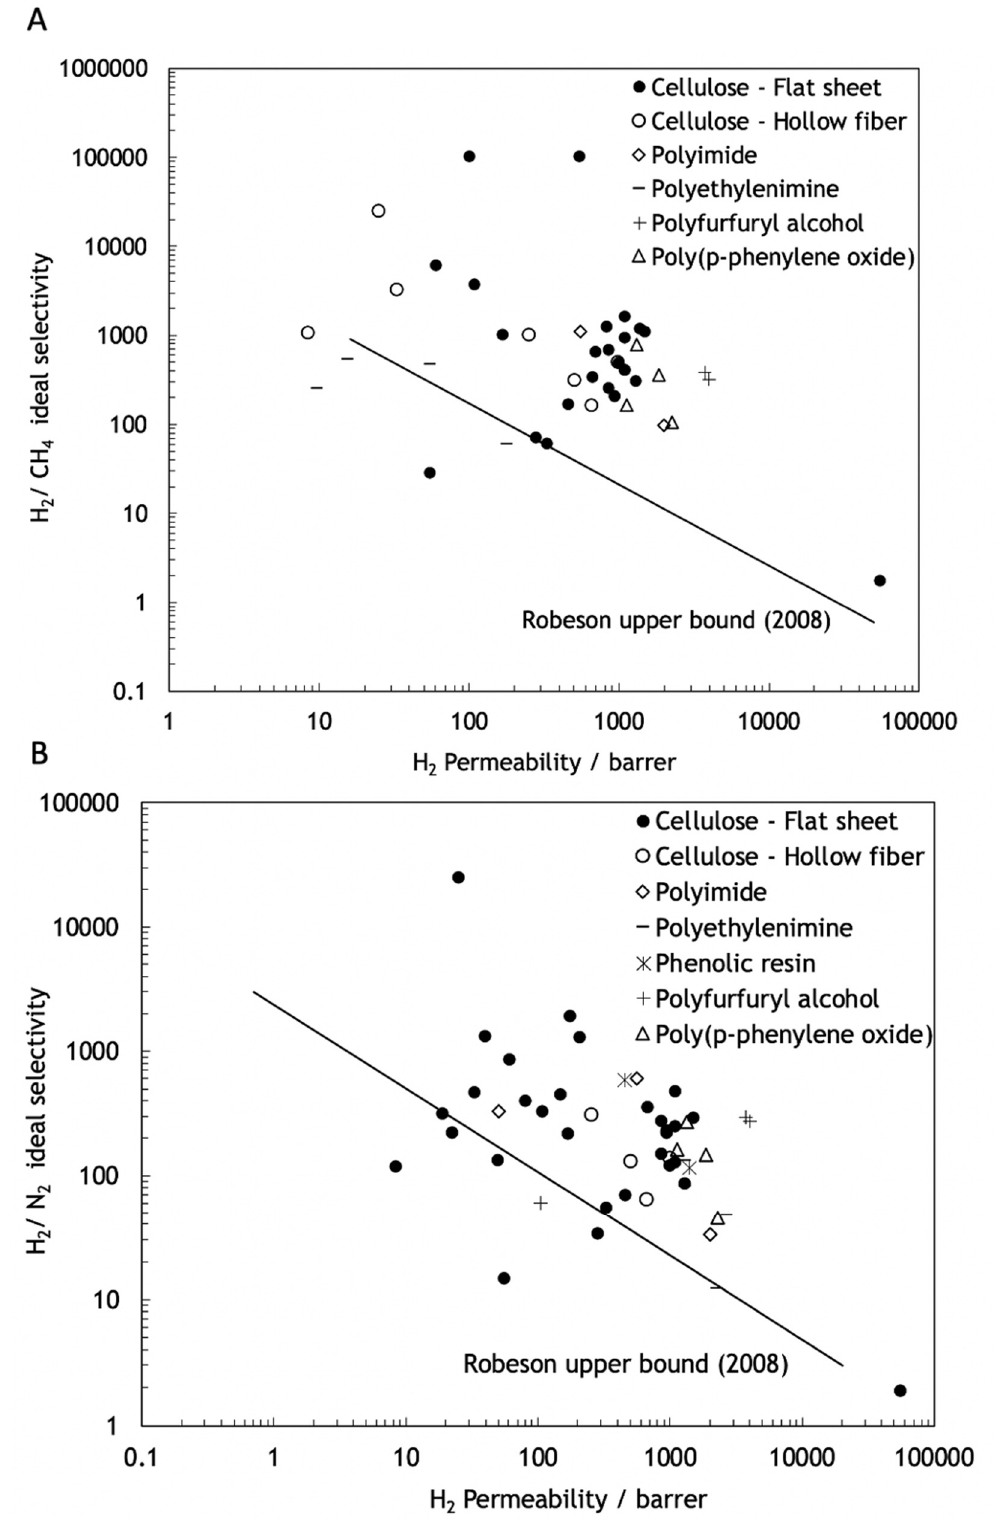
Figure 13. Separation performance of CMSM with different polymeric precursors for: ( A ) H 2 /CH 4 separation; ( B ) H 2 /N 2 separation.